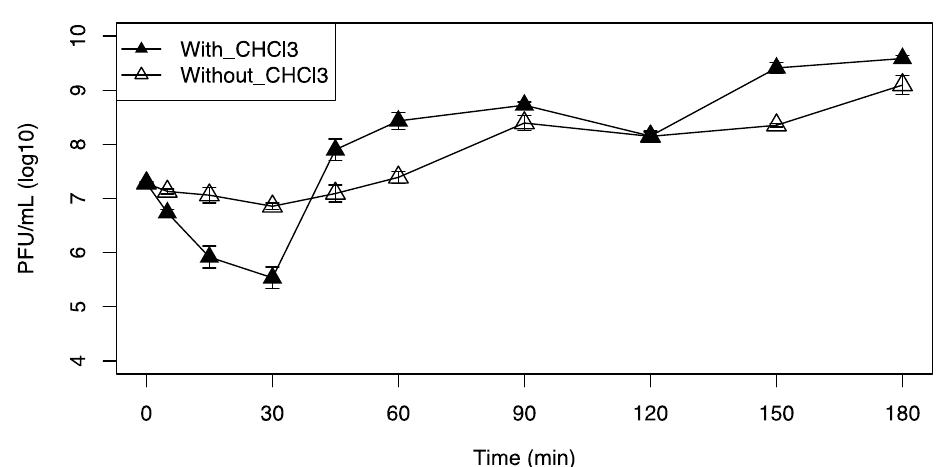
Figure 4. One-step growth curve of Listeria monocytogenes F2365 treated with ( A ) LP-20, ( B ) LP-0-27, or ( C ) LP-094 at a MOI = 0.1 at 25 °C. Filled triangles represent the phage titer in chloroform treated samples and unfilled triangles represent the phage titer in untreated samples. Data are mean values of three biological replicates and error bars represent standard error.